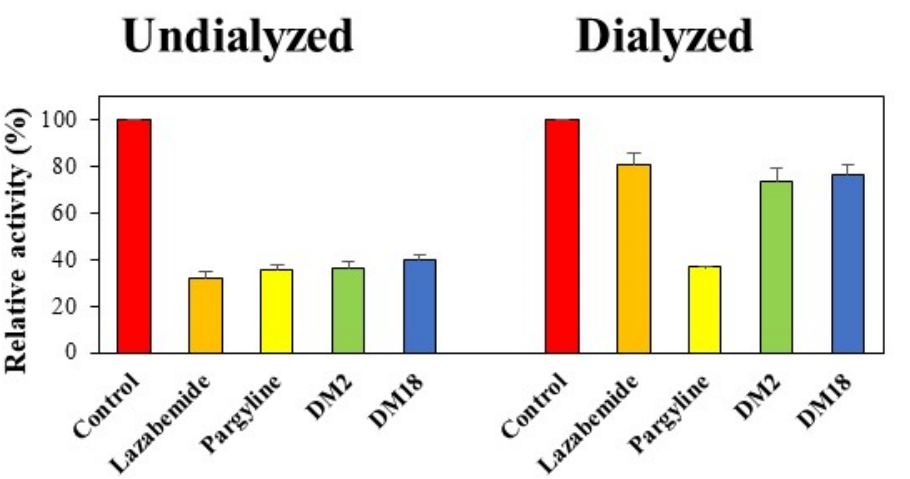
Figure 4. Recoveries of MAO-B inhibitions by DM2 and DM18 using dialysis experiments.